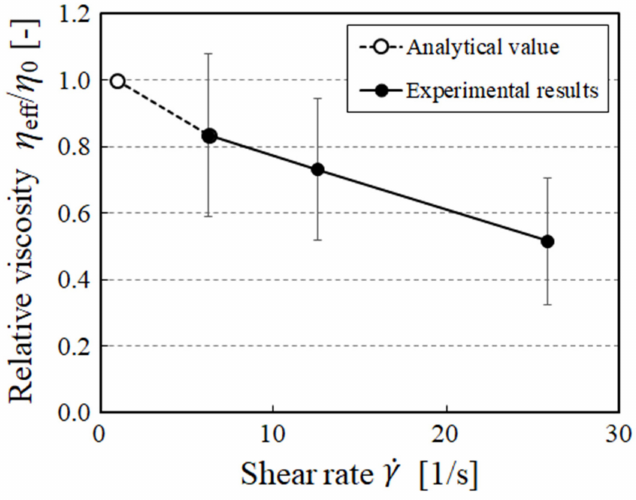
. γ . The plots are the mean ±